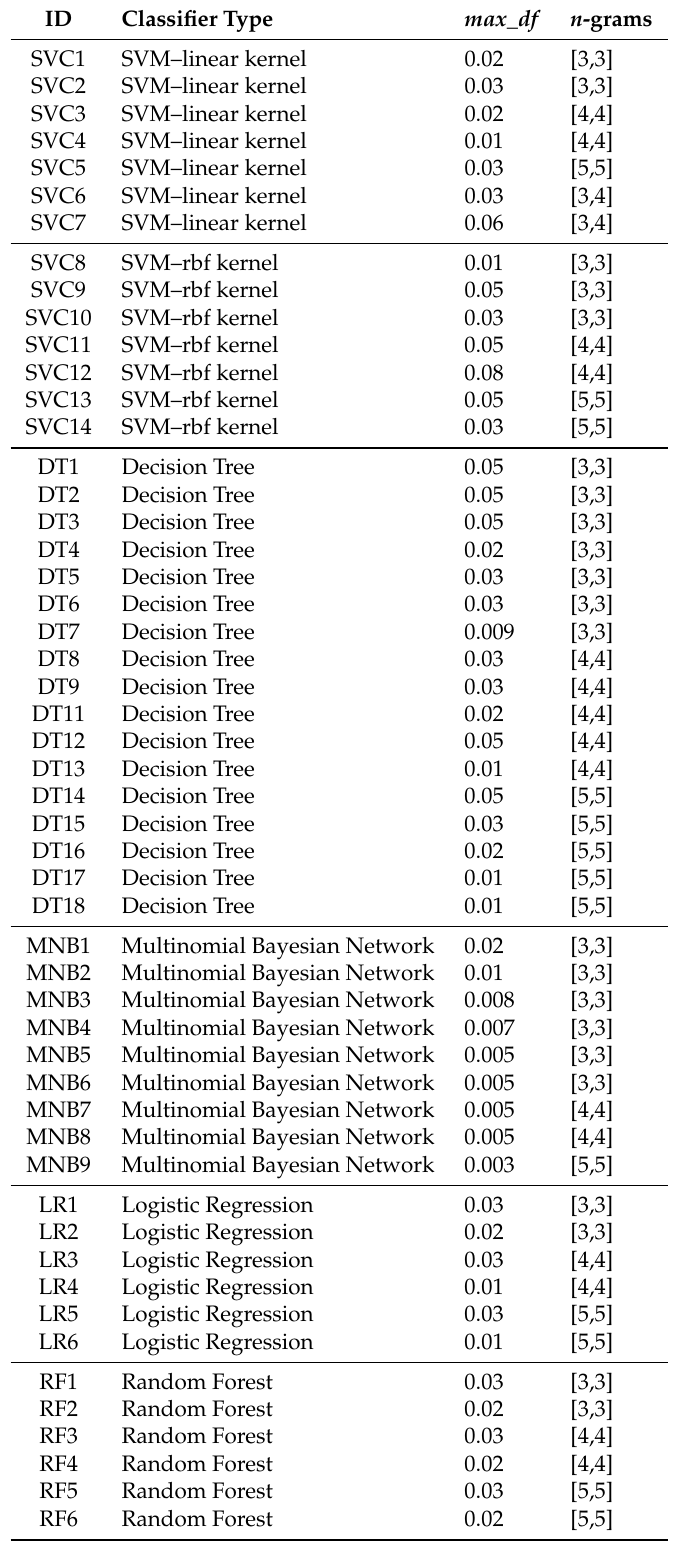
Table 2. Complete description of hyperparameter settings for all classifier